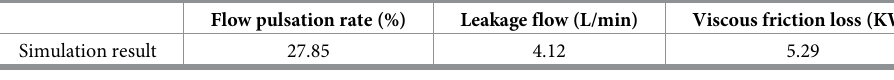
Table 13. Simulation values corresponding to the optimal clearances.